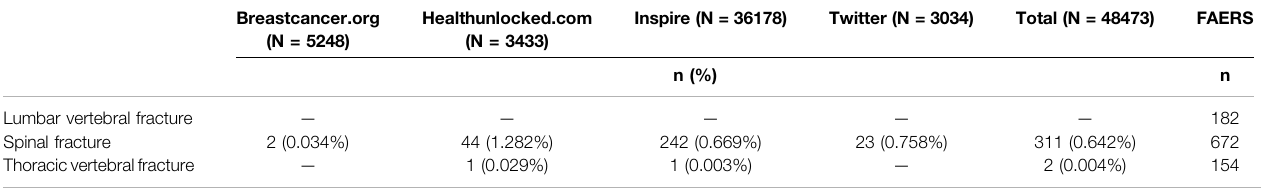
TABLE 3 | Adverse events of interest (by MedDRA preferred term) identi fi ed in posts mentioning denosumab. Breastcancer.org (N = 5248)